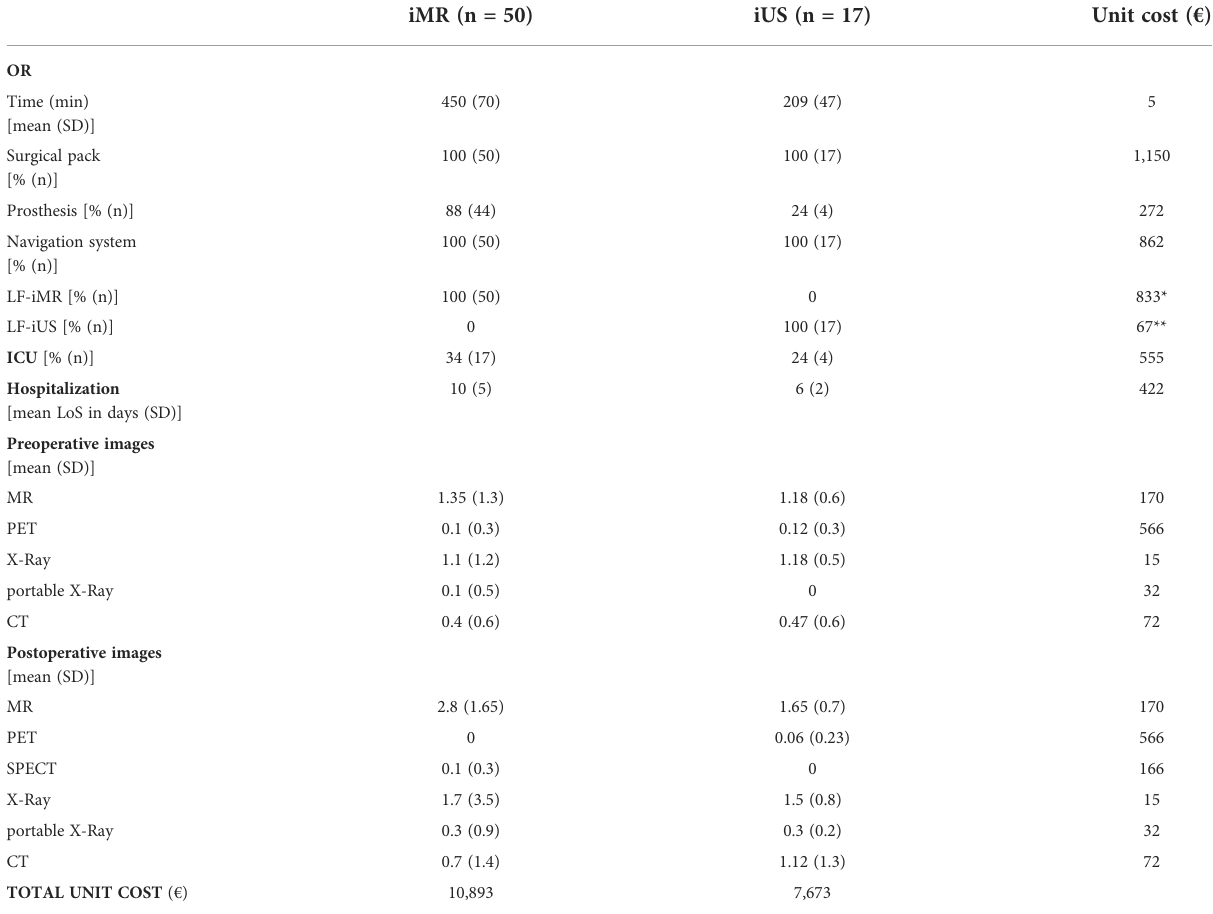
TABLE 3 Resources used and computed unit